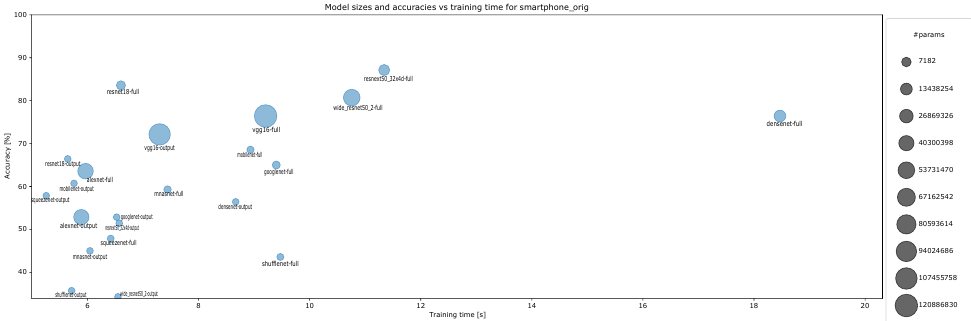
Figure A20. Accuracy vs, training time and model size for Hymenoptera for one-episode training.